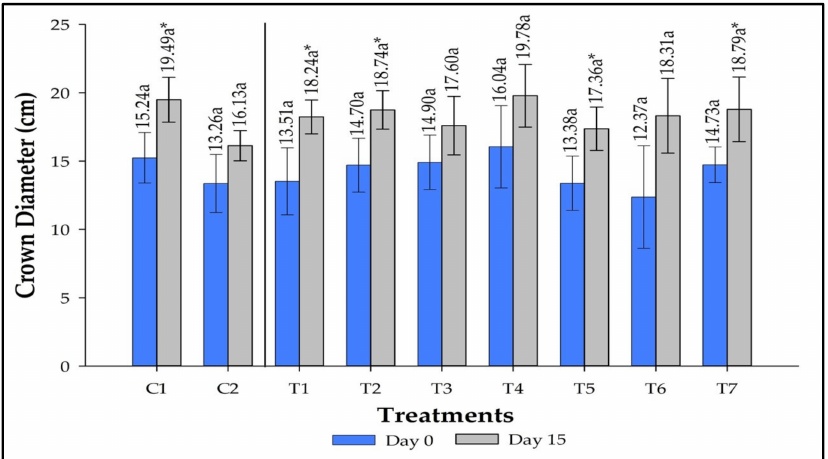
Figure 2. Crown diameter extension in strawberries inoculated with Azospirillum brasilense , Bacillus megaterium , and Brevibacillus fluminis , alone and in mixtures on days 0 and 15. Means followed by the same letter do not differ significantly according to Duncan’s test ( p ≤ 0.05). Means on Day 15 followed by asterisks (*) differ statistically from the corresponding mean on Day 0 according to the paired Student’s t -test ( p ≤ 0.01). C1: control without inoculation + fertilization 100% of N and